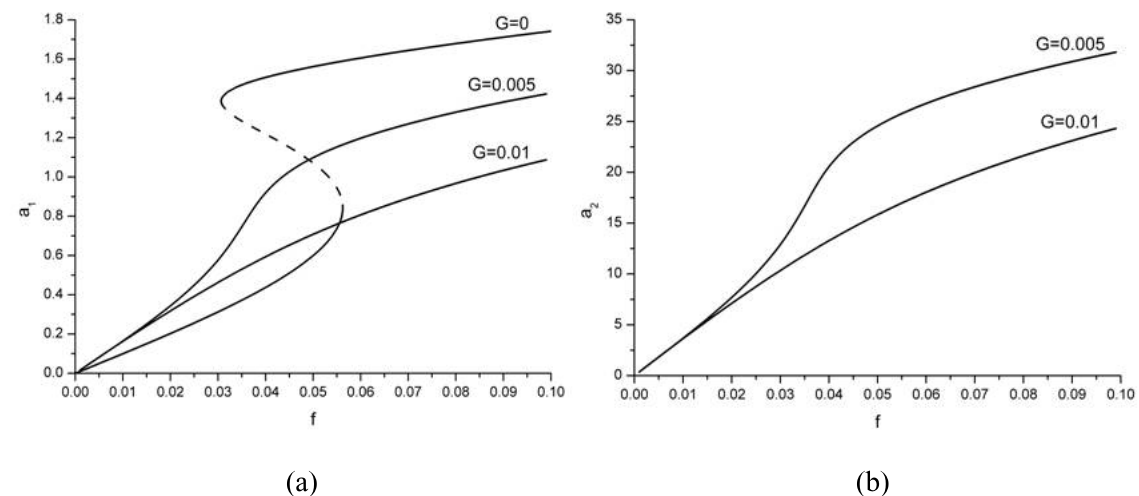
Fig. 9. Effect of varying the feedback gain on the force-response curves of (a) the plant and (b) the absorber when σ 1 = − 0 . 1 , ζ = 0 . 01 and ν 2 = − 0 . 02